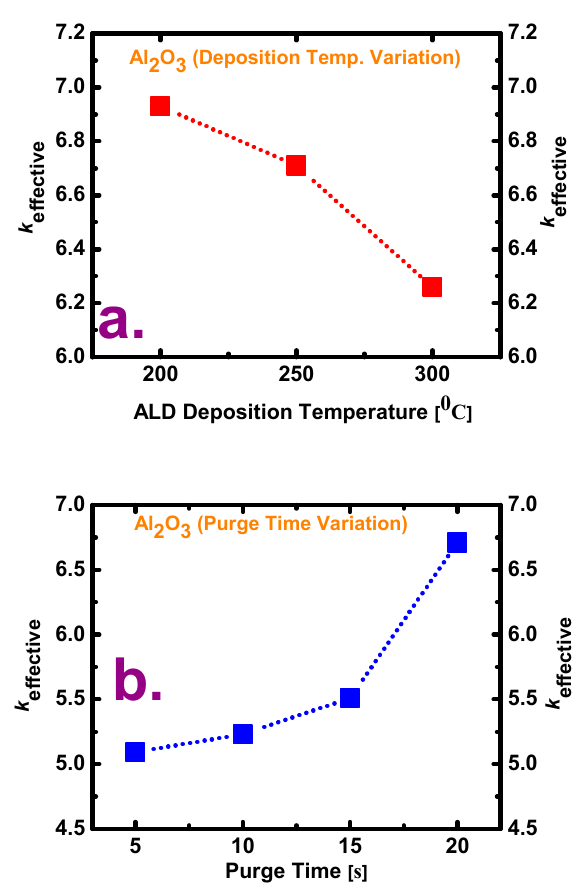
10, 15, and 20 s are 5.091, 5.23, 5.51, and 6.71, respectively. From these results, it is evident that a film deposited at a lower ALD temperature and with a longer purge time shows a higher permittivity, which means that it has better insulation properties.